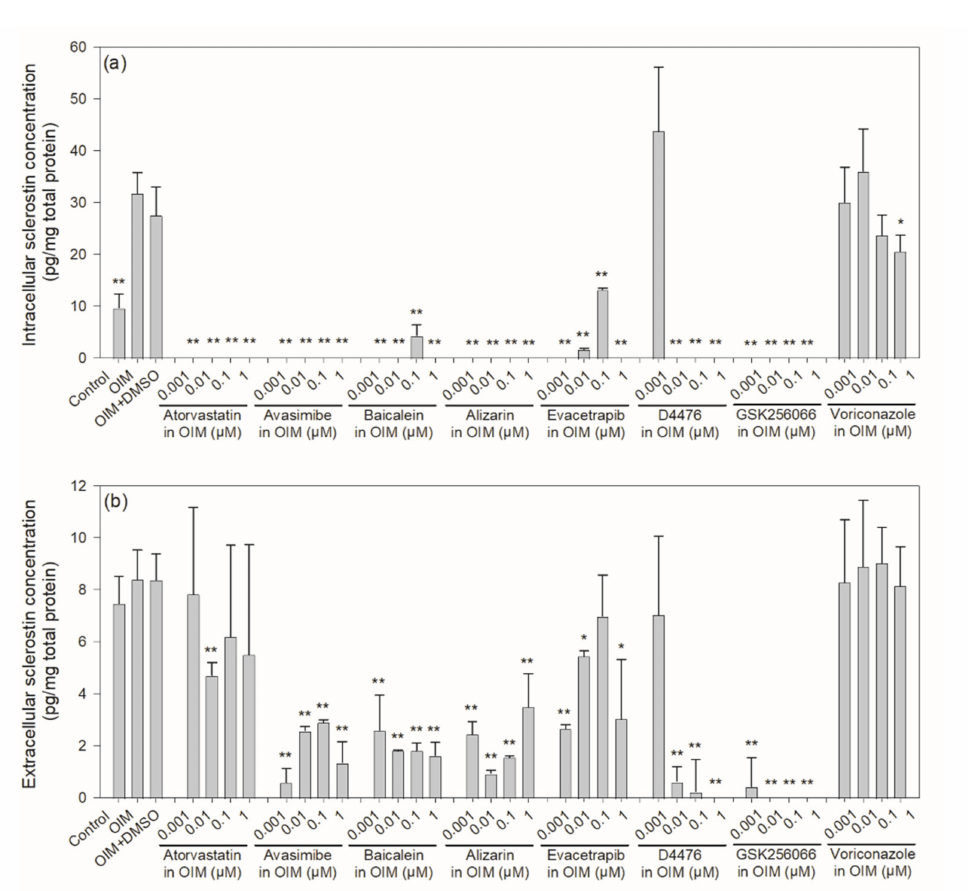
Figure 5. Intracellular and extracellular levels of sclerostin in IDG-SW3 cells treated with various concentrations of potential sclerostin-binding inhibitors. IDG-SW3 cells were treated with 0.001-1 µ M of one of the 6 potential sclerostin inhibitors, as well as the negative controls GSK256066 and voriconazole, in OIM for 21 days, followed by collection of the cell lysate and conditioned medium to determine the ( a ) intracellular and ( b ) extracellular sclerostin concentration, respectively, with a mouse sclerostin ELISA kit. The concentration of sclerostin was expressed as the amount of sclerostin (pg) normalized to total protein (mg) in the cell lysate or conditioned medium. Error bars represent standard deviations ( n ≥ 3). * p < 0.05 and ** p < 0.01 compared to the OIM